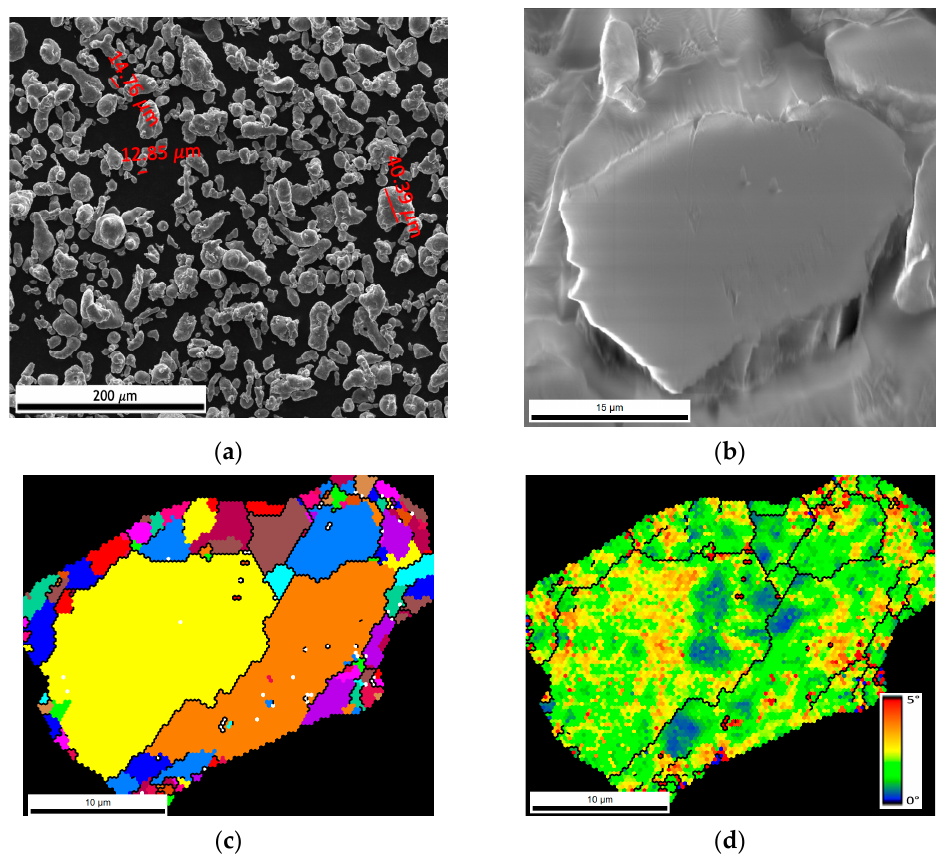
Figure 1. ( a ) Scanning electron microscopy (SEM) image of Al powder, ( b ) higher magnification of SEM image showing an Al particle, ( c ) unique grain colour map showing that more than one grain is present in the Al particle, where each colour represents a different grain, and ( d ) Kernel average misorientation (KAM) map.